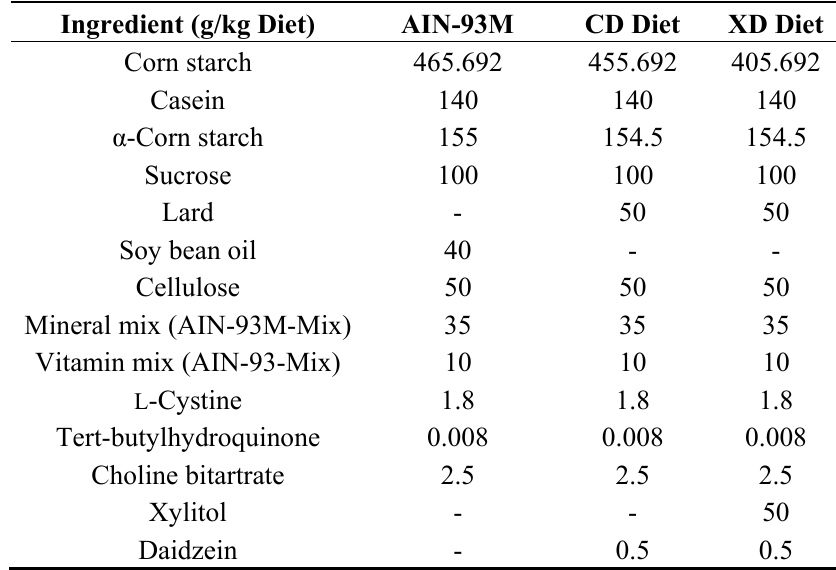
Table 1. Composition of the experimental